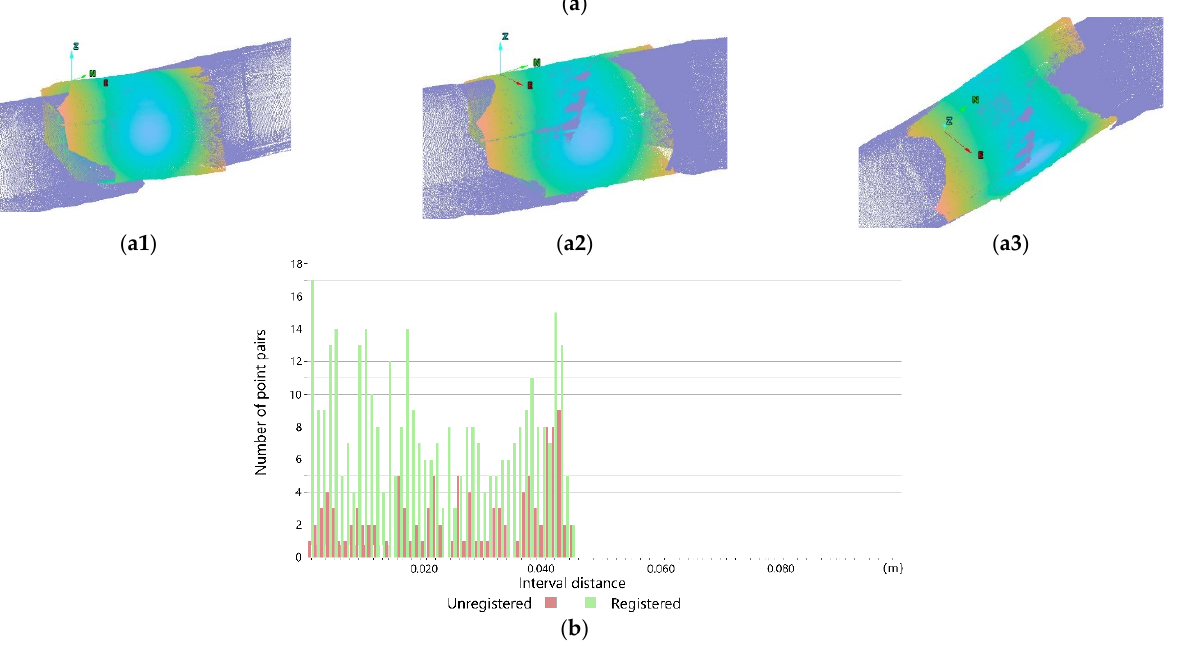
Figure 17. ( a ) Point cloud patching diagram of 3D-NDT algorithm. ( a1 ) Initial pose; ( a2 ) Fine registration side view; ( a3 ) Fine registration top view. ( b ) Fine registration verification diagram.